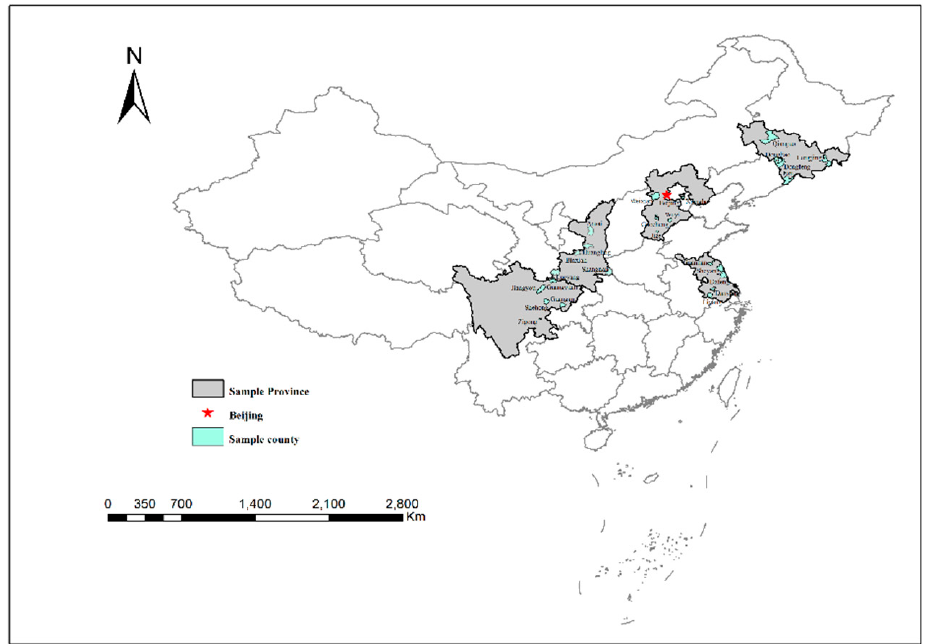
Figure 1. Location of the sample provinces and counties.